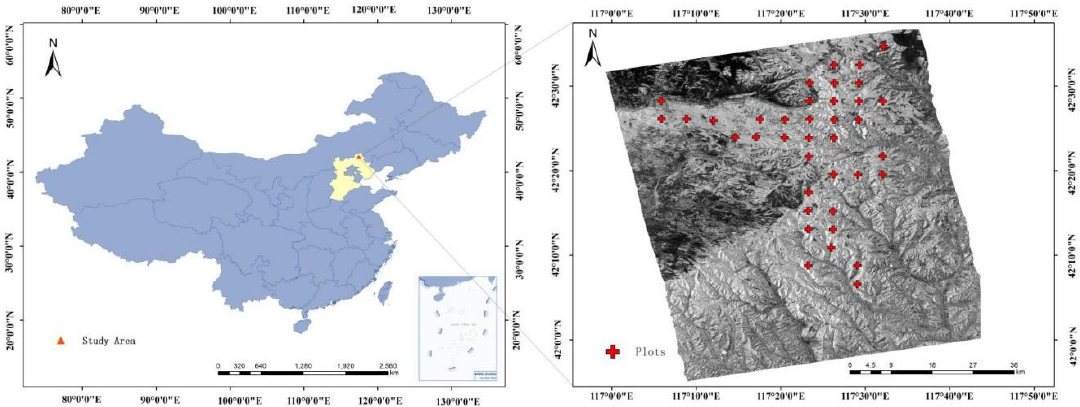
Figure 1. SAR data illustration of sample